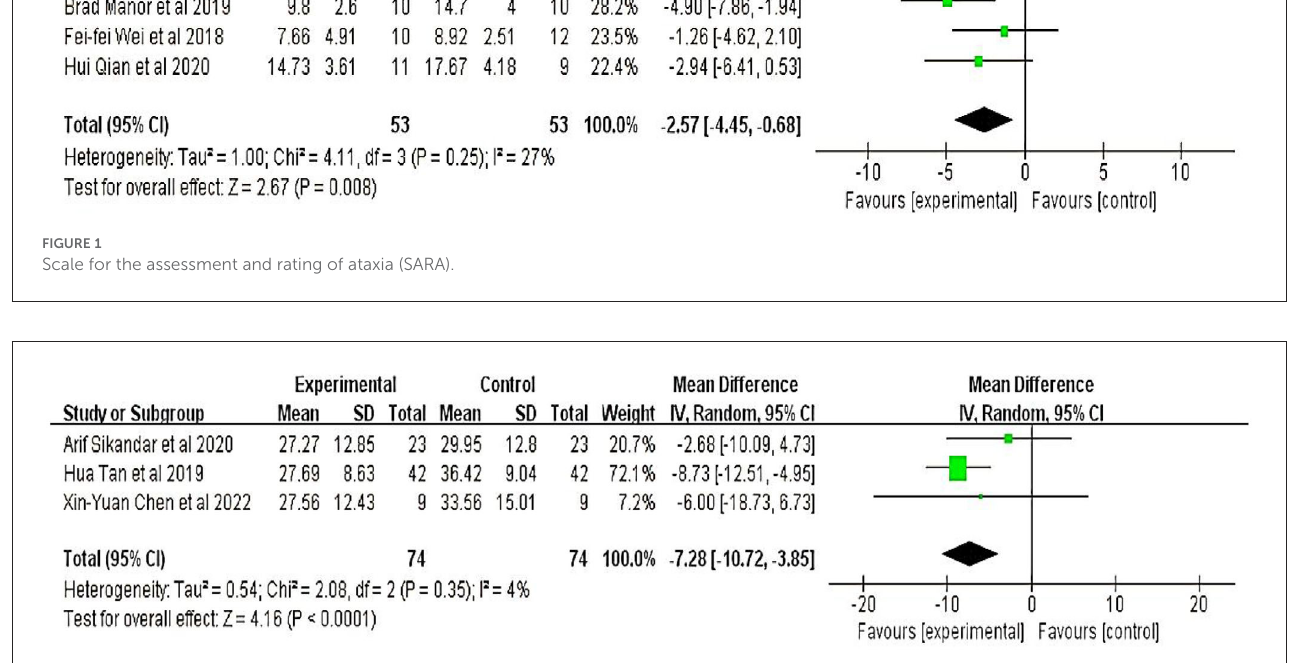
FIGURE2 International Cooperative Ataxia Rating Scale